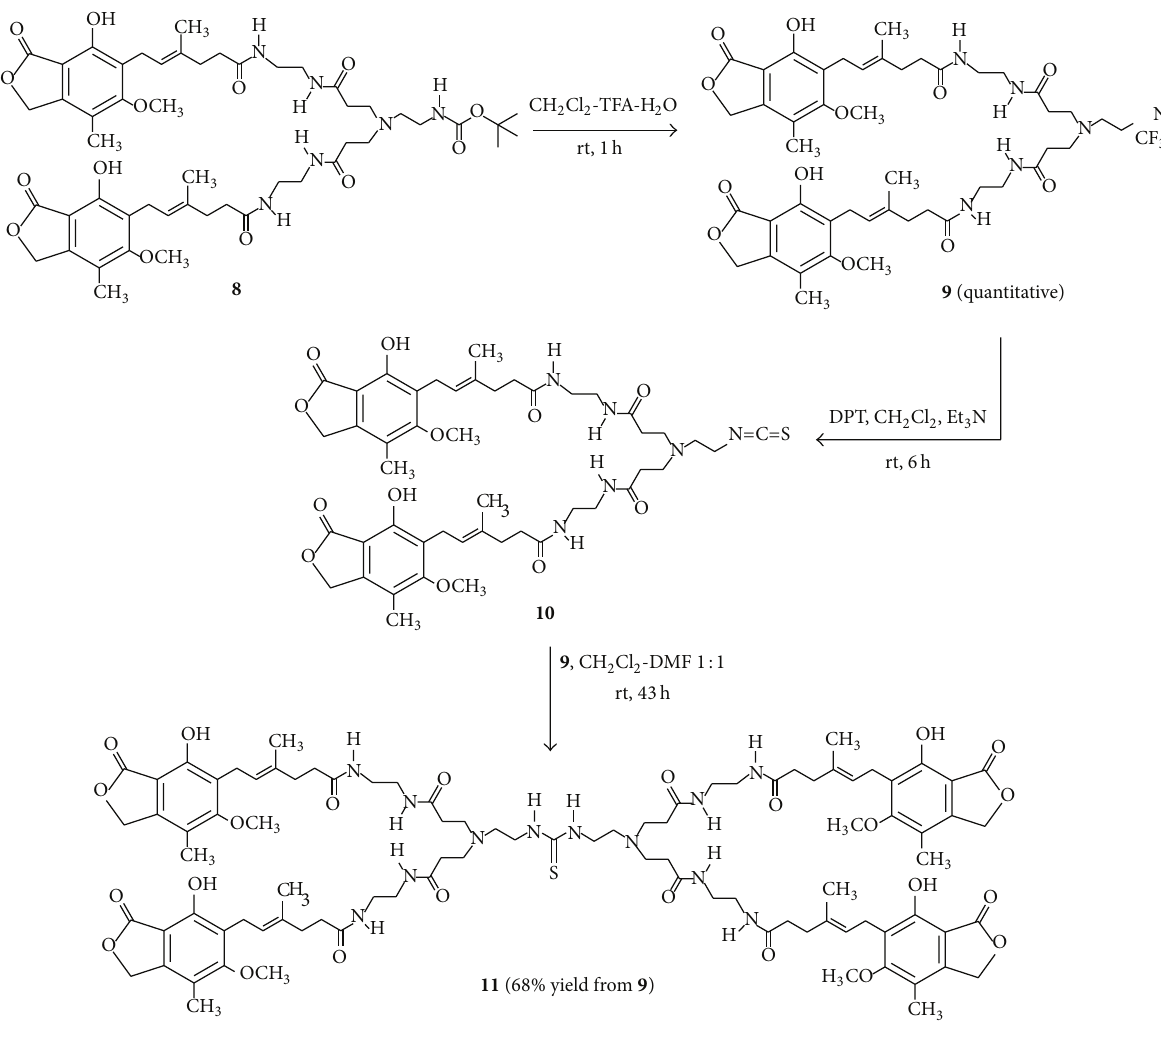
Scheme 3: Synthesis of dendrimer 11